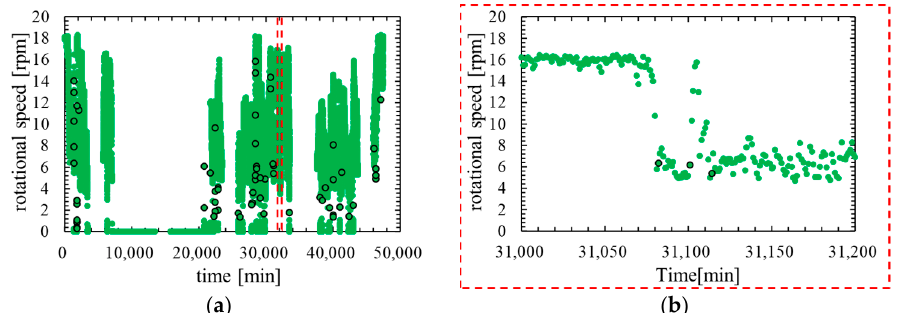
Figure 2. Wind speed rotational speed characteristic.